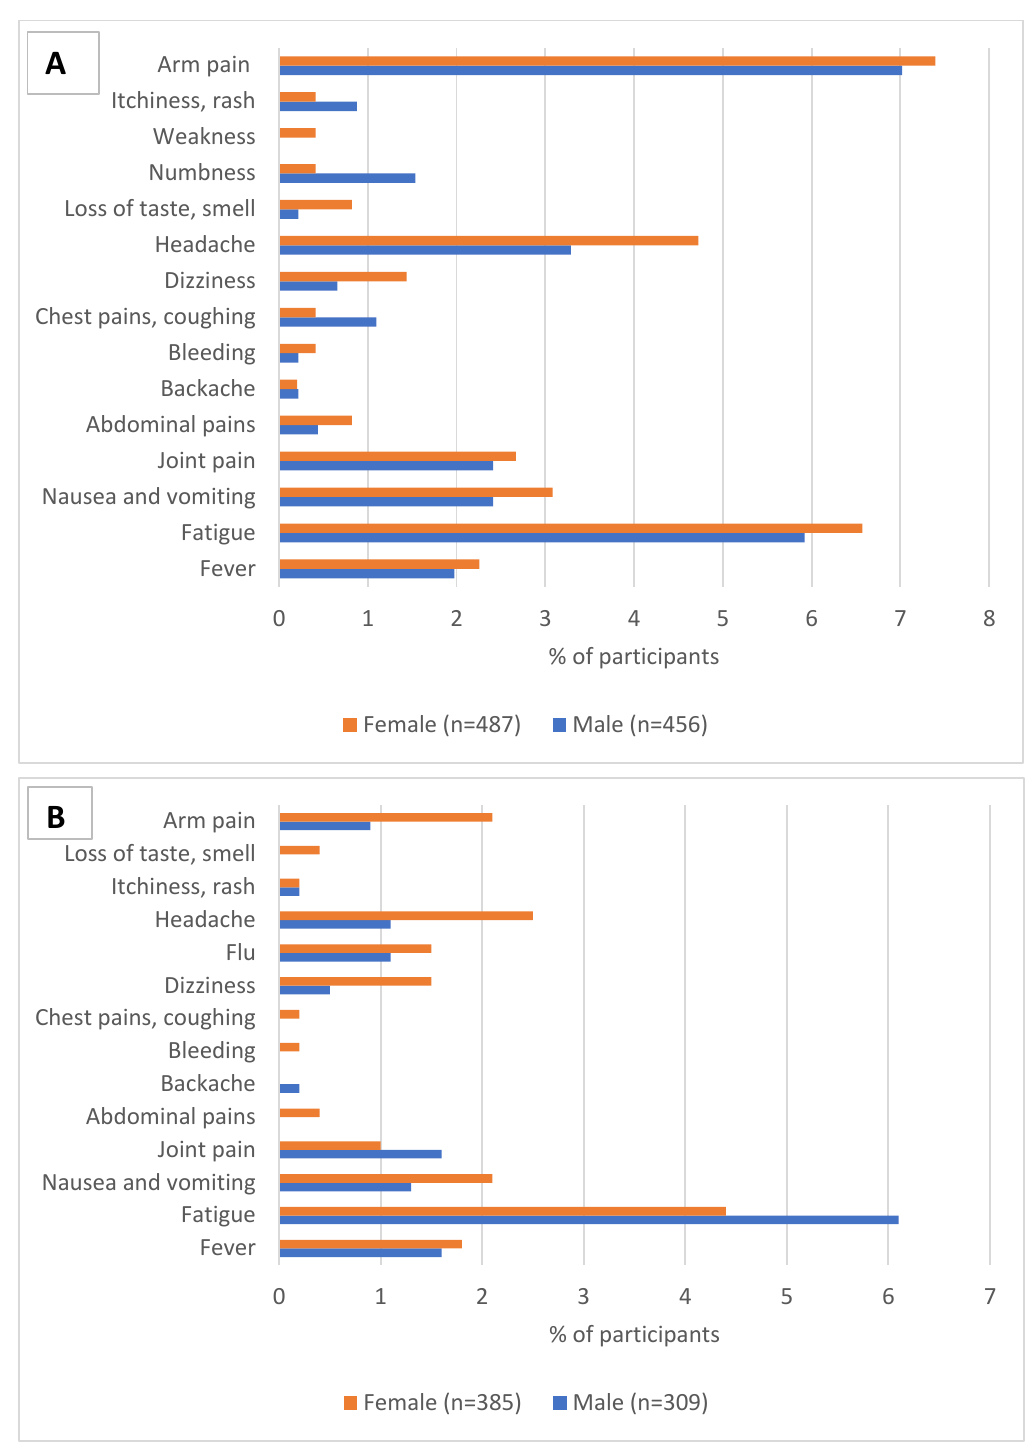
Figure 1. Frequency of vaccination adverse events by sex for the two doses ( A ) adverse events following first dose; ( B ) adverse events following second dose. We evaluated factors associated with the presence of at least one side effect following the first and second dose. Participants who had personal COVID-19 experience were less likely to report a side effect than those with no experience (OR 0.67; 95%CI: 0.49 – 0.90). Similarly, participants who perceived Sinovac/Sinopharm vaccines as safe (OR 0.59, 95%CI 0.44, 0.80) were less likely to report experiencing a side effect after the first dose (Table 5).